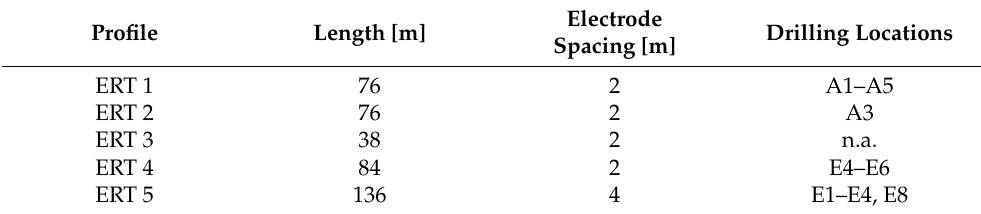
Table 1. Name, length, electrode spacing, and drilling locations of 2D ERT